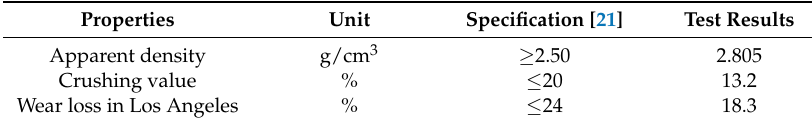
Table 4. Properties of aggregate.